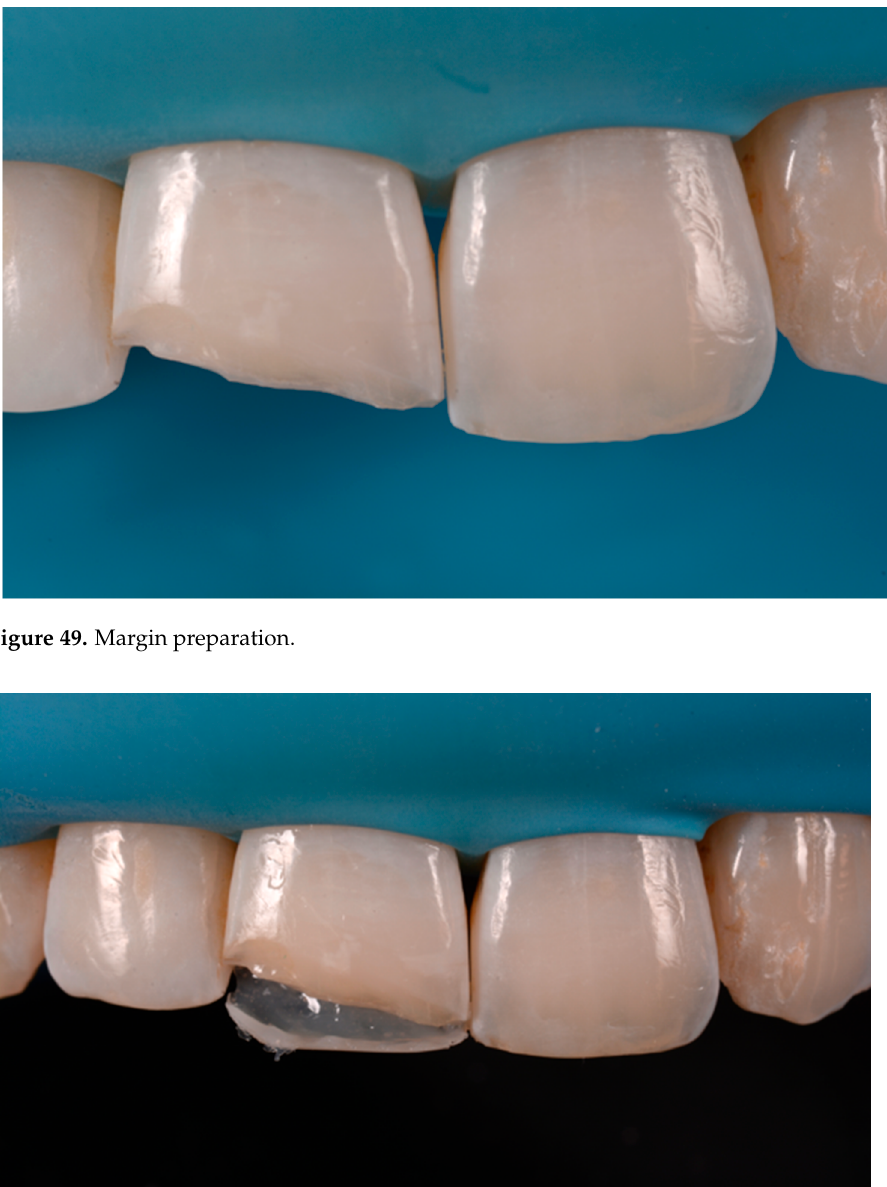
Figure 48. Initial clinical situation.